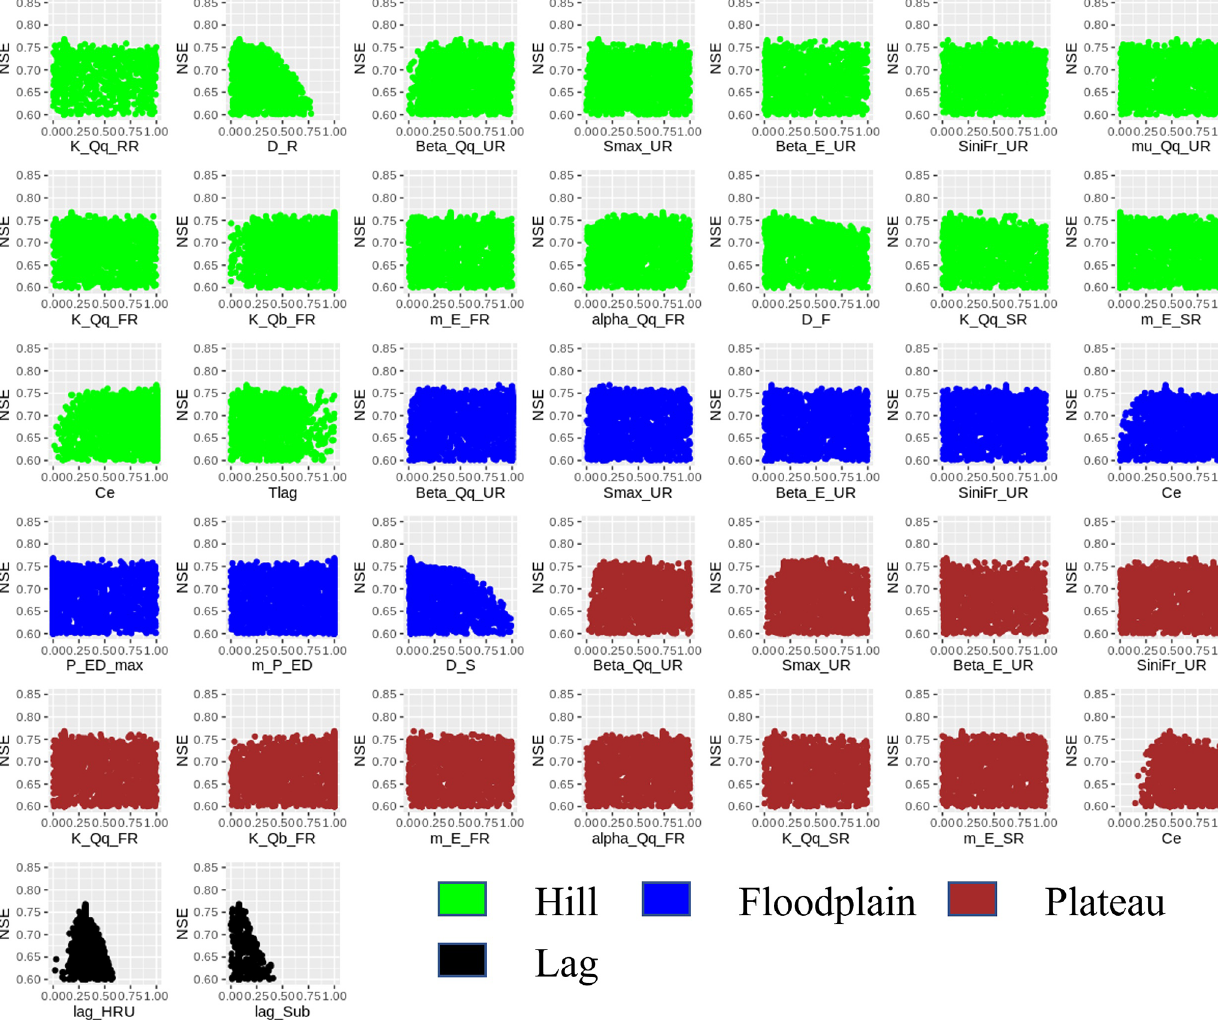
Figure A1. Sensitivity scatterplots of